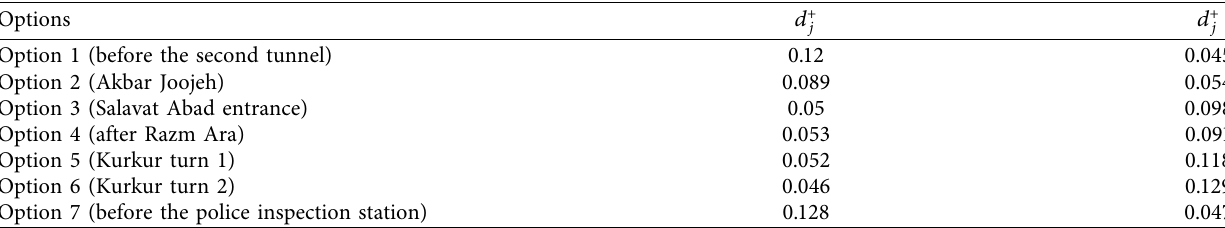
d − j and j for each option.